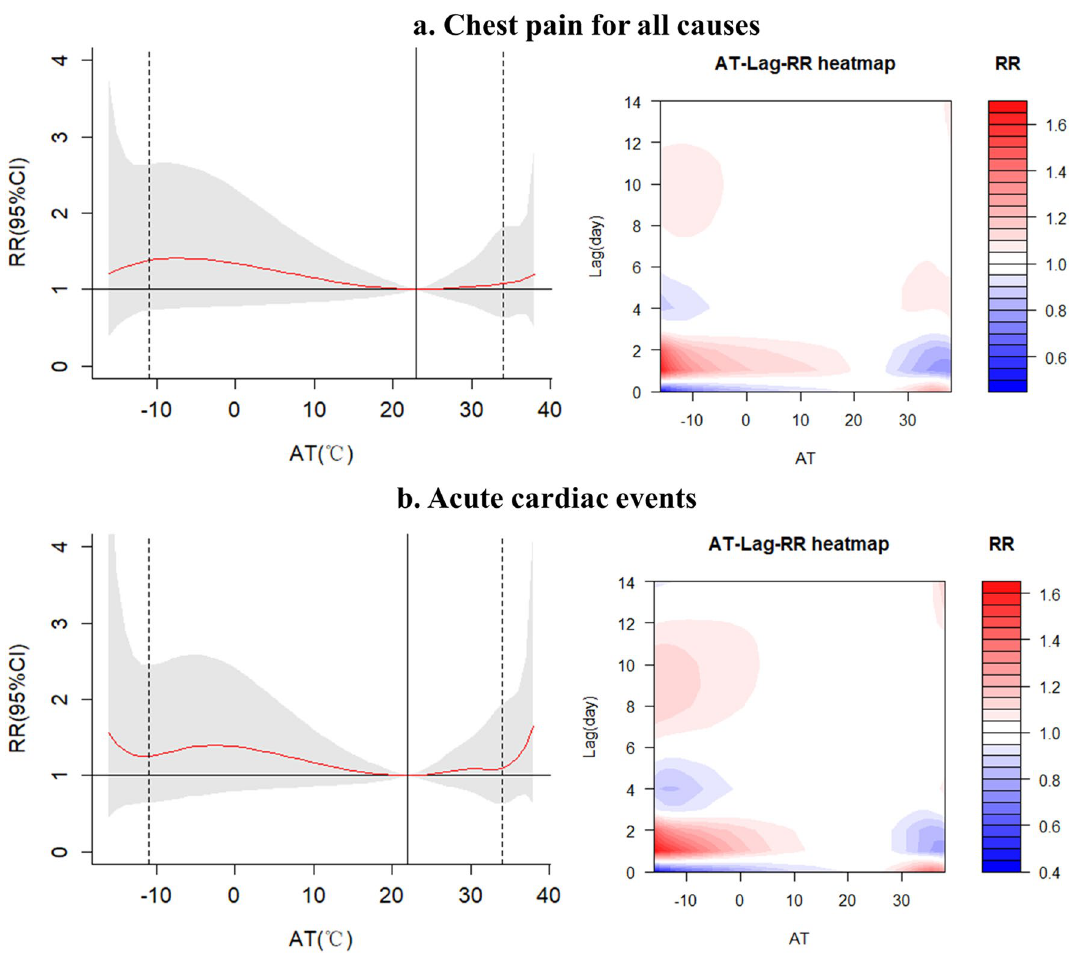
Figure 2. Exposure–response relationship between apparent temperature (AT) and daily hospital admissions due to chest pain in 10 public hospitals in Beijing, China (with reference of the Minimum Admission Apparent Temperature, MAAT).